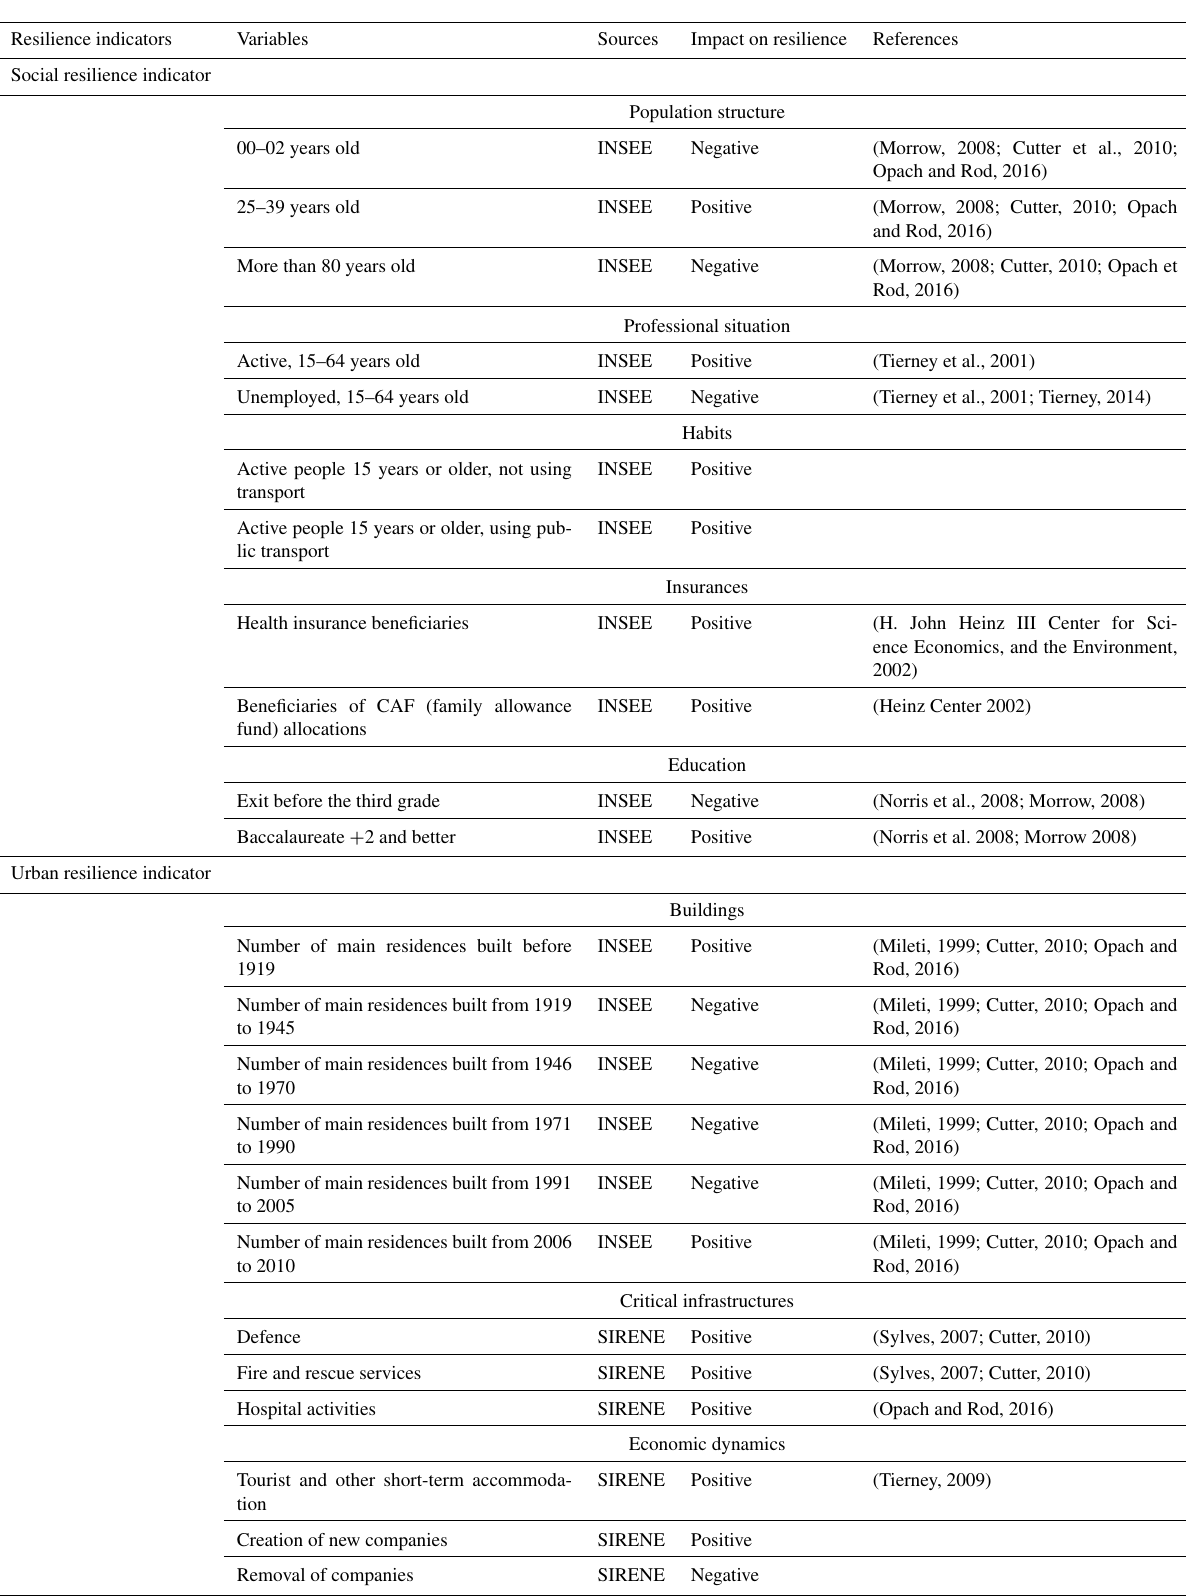
Table 1. Example of data selection, sources and